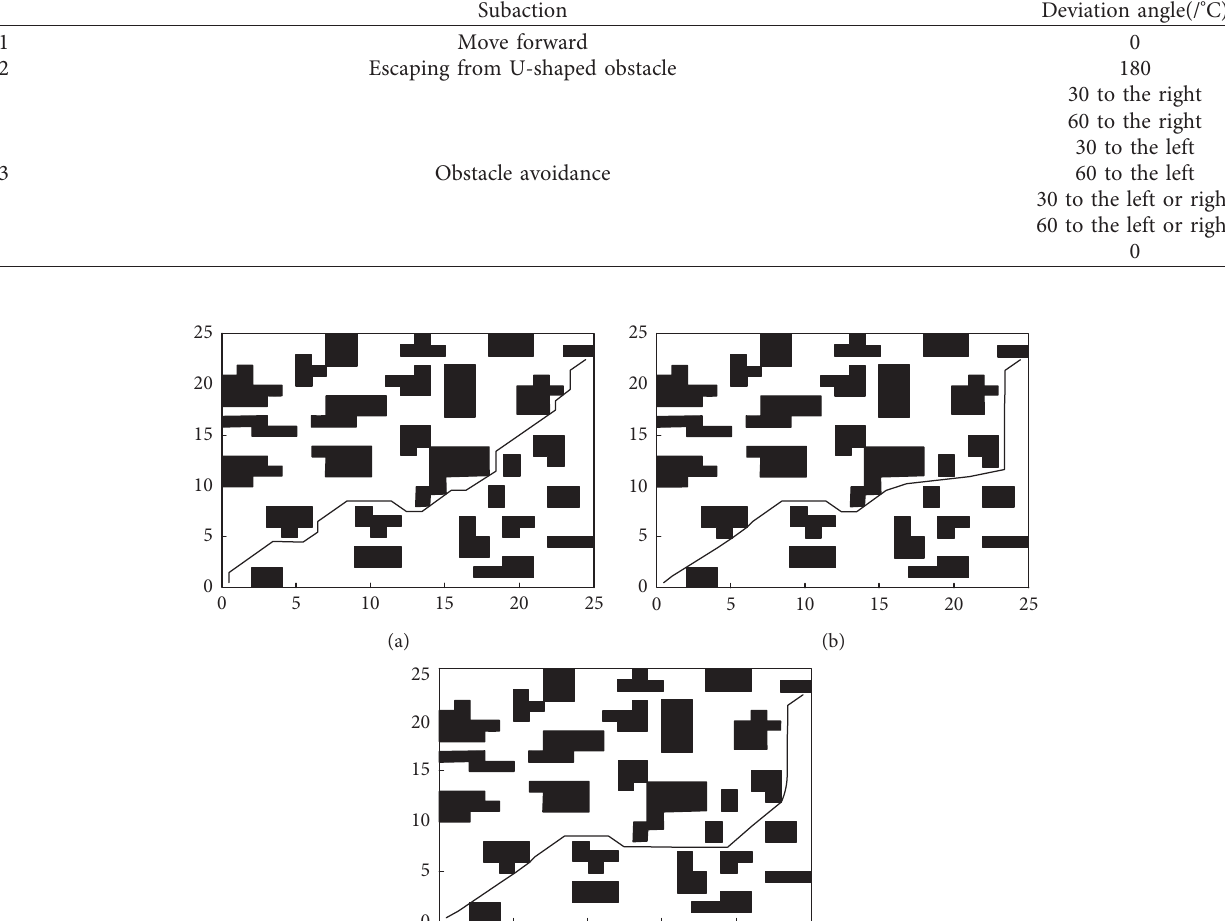
Table 3: Action selection details.